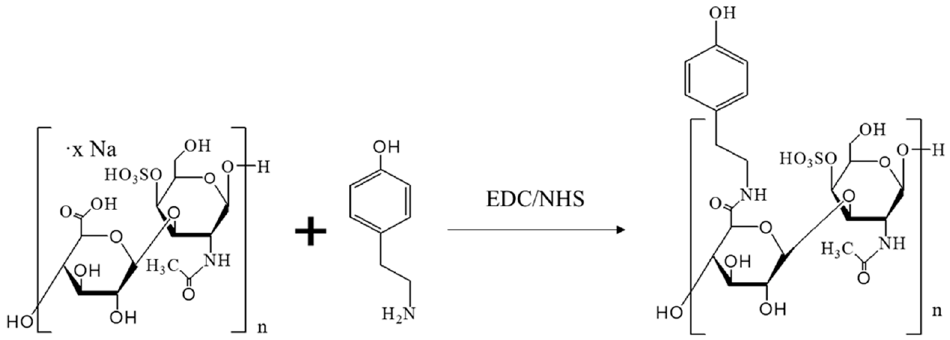
Figure 8. Chemical synthesis of CS-Tyr through EDC/NHS reaction.